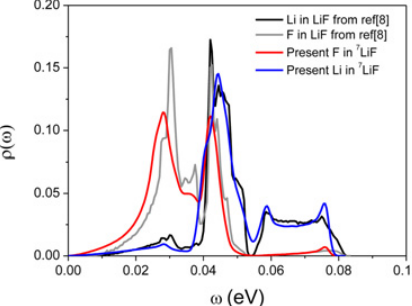
Figure 2. The calculated partial PDOSs of 7 Li and F atoms.